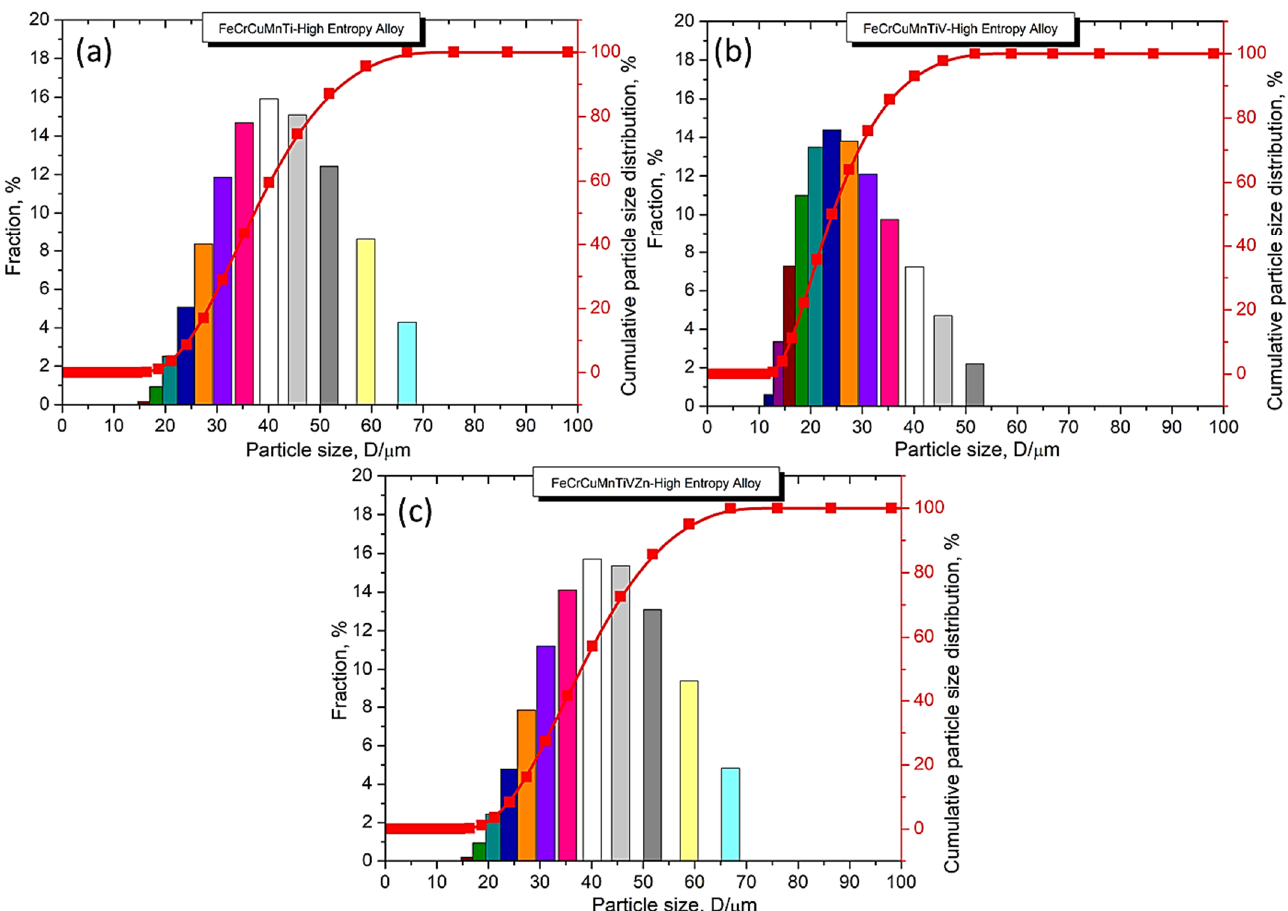
Figure 8. Particle size distribution of three developed high entropy alloy powders: ( a ) HEA1-FeCrCuMnTi; ( b ) HEA2- FeCrCuMnTiV; and ( c ) HEA3-FeCrCuMnTiVZn.